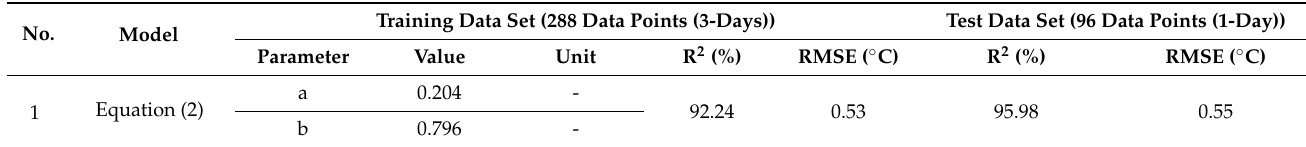
Table 7. Grey-box model for prediction T ma as influenced by regressor sensors T oa and T ra Table 7 . Grey ‐ box model for prediction T ma as influenced by regressor sensors T oa and T ra .